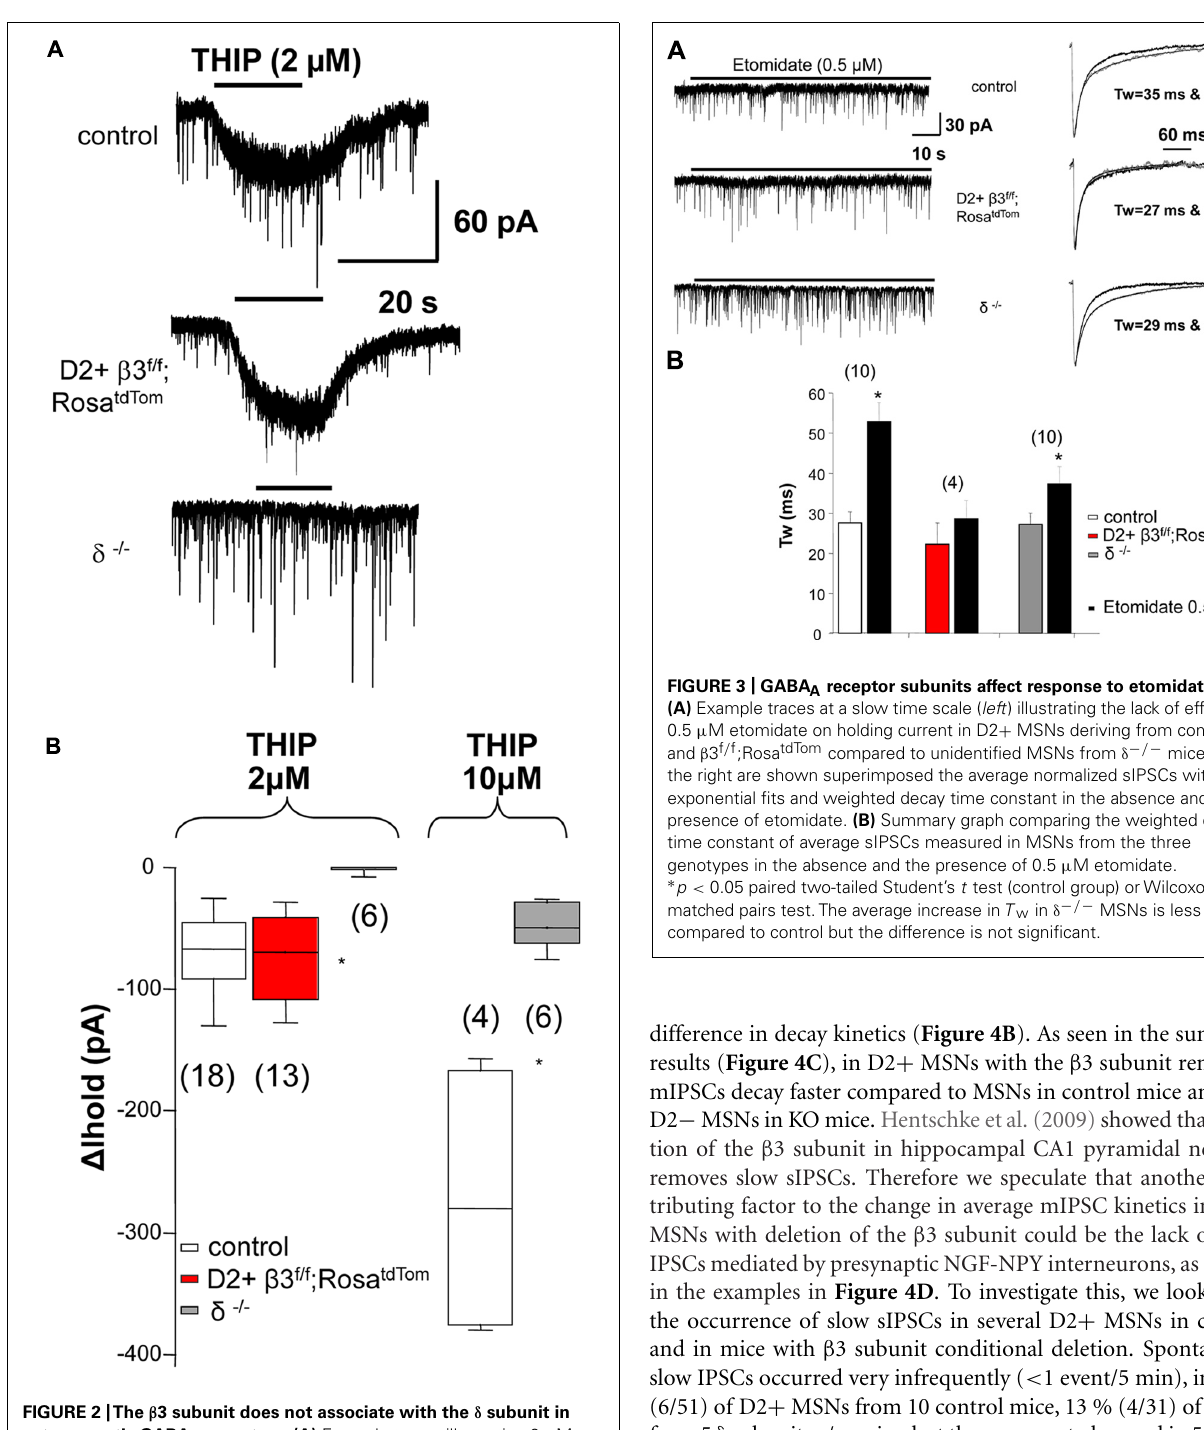
FIGURE 2 |The β 3 subunit does not associate with the δ subunit in extrasynaptic GABA A receptors. (A) Example traces illustrating 2 μ M THIP induced current in control MSNs and D2 + MSNs from β 3 f / f ;Rosa tdTom mice and the lack of response in MSN from δ − / − mice Summary of the data obtained is shown in (B) together with the summary of currents ( (cid:3) I hold ) elicited by 10 μ MTHIP compared between MSN from control and δ − / − mice. Note that at 10 μ MTHIP begins to activate non δ -containing receptors ∗ p < 0.05. One-way ANOVA for repeated measures followed by Dunn’s post hoc test for the 2 μ MTHIP cell groups while the Mann–Whitney test was used for the 10 μ MTHIP groups.